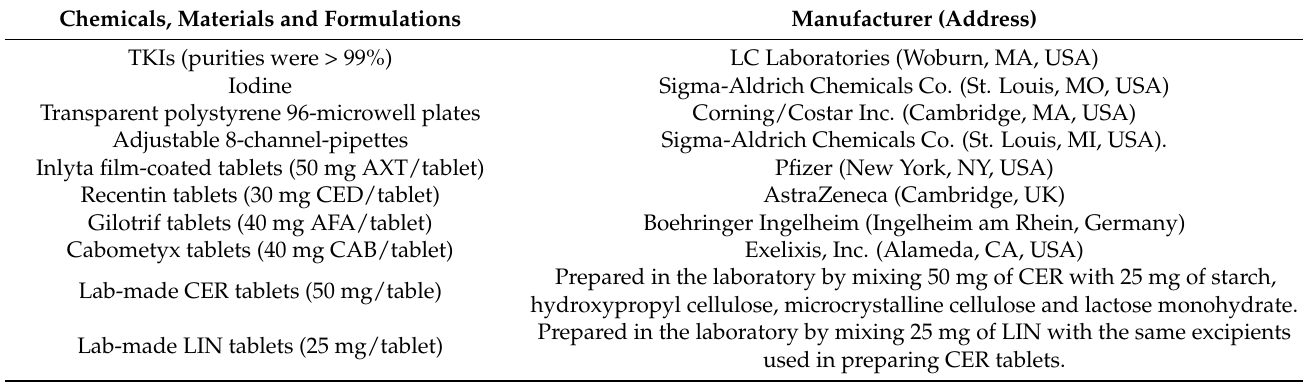
Table 2. Chemicals, materials and pharmaceutical formulations used in the